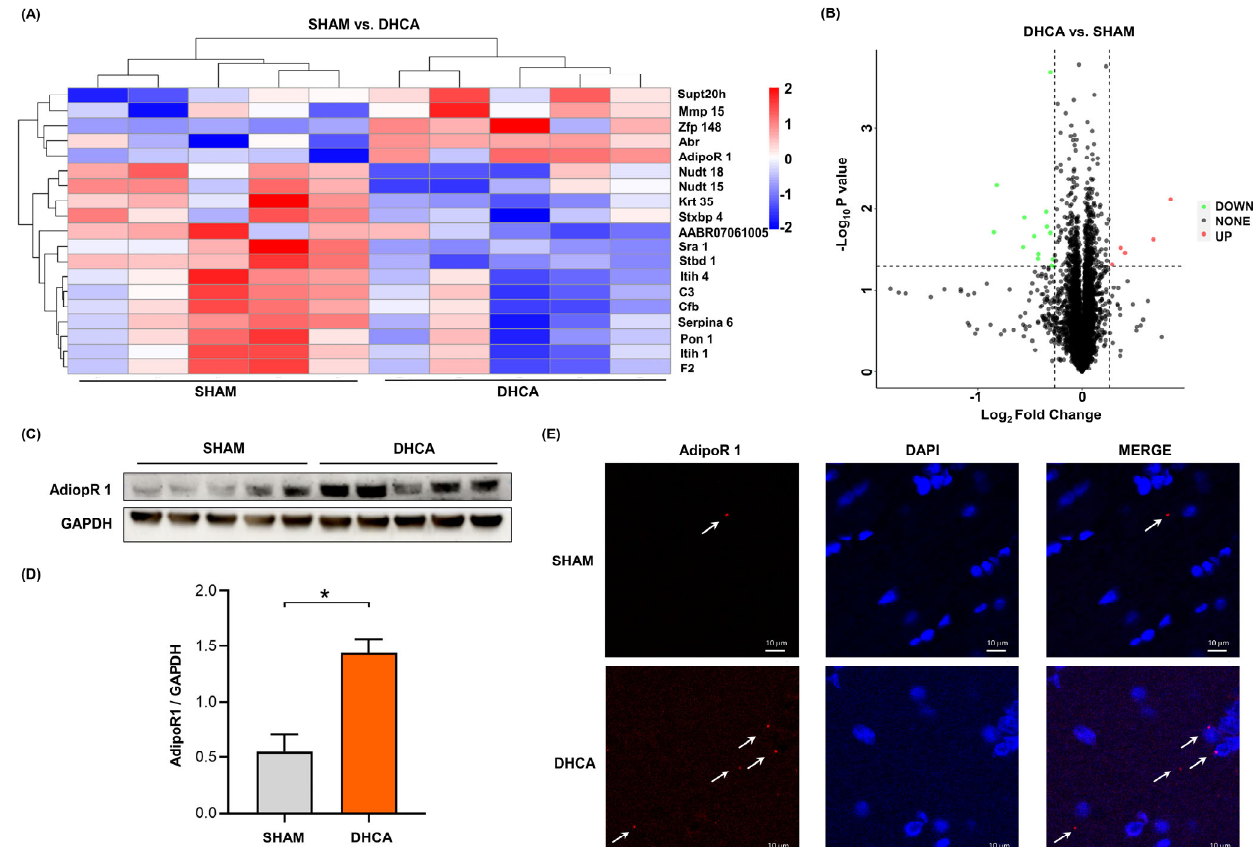
Figure 1. Differentially expressed proteins of the hippocampus after DHCA and the expression of adiponectin receptor 1. ( A ) Cluster analysis of differentially expressed proteins (DEPs) in DHCA rats compared with rats in the sham groups. Each group contained five biological replicates. ( B ) The volcano plot displayed DEPs. The orange and green spots indicate upregulated and downregulated proteins, respectively. Additionally, the gray spots represent proteins that did not meet the setting criteria. ( C ) The expression of adiponectin receptor 1 (AdipoR 1) protein in hippocampus. ( D ) Quantitative analysis of the AdipoR 1 protein according to the Western blot results. ( E ) Immunofluorescence results of the expression of AdipoR 1 protein in hippocampus. The white arrows indicate the AdipoR 1 protein. Scale bar: 10 μ m. AdipoR 1: adiponectin receptor 1. * p < 0.05